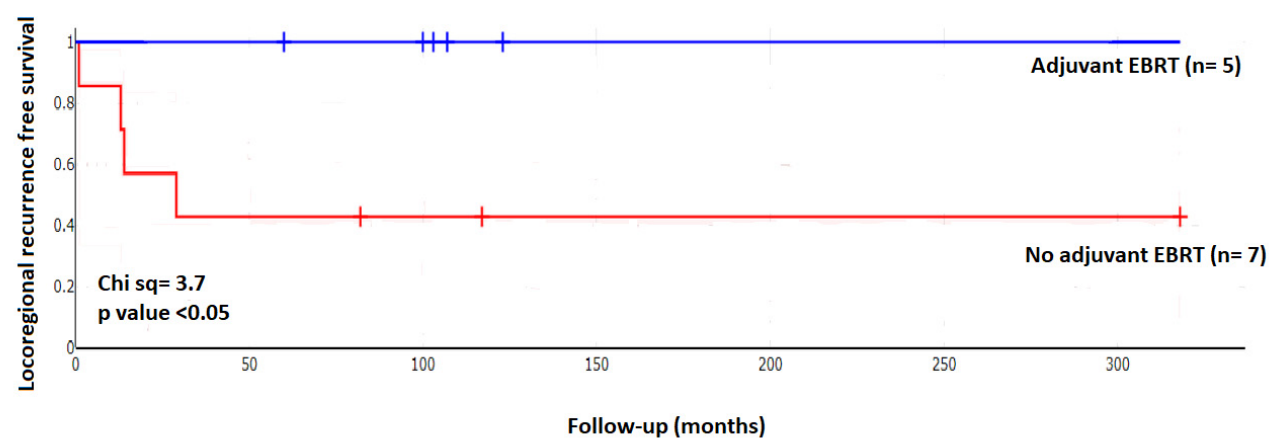
Figure 2. Kaplan–Meier plot of locoregional recurrence free survival following adjuvant EBRT; χ 2 = 3.72 p = 0.05. In 8 patients with R1 resection margins following initial surgery, 12 situations of